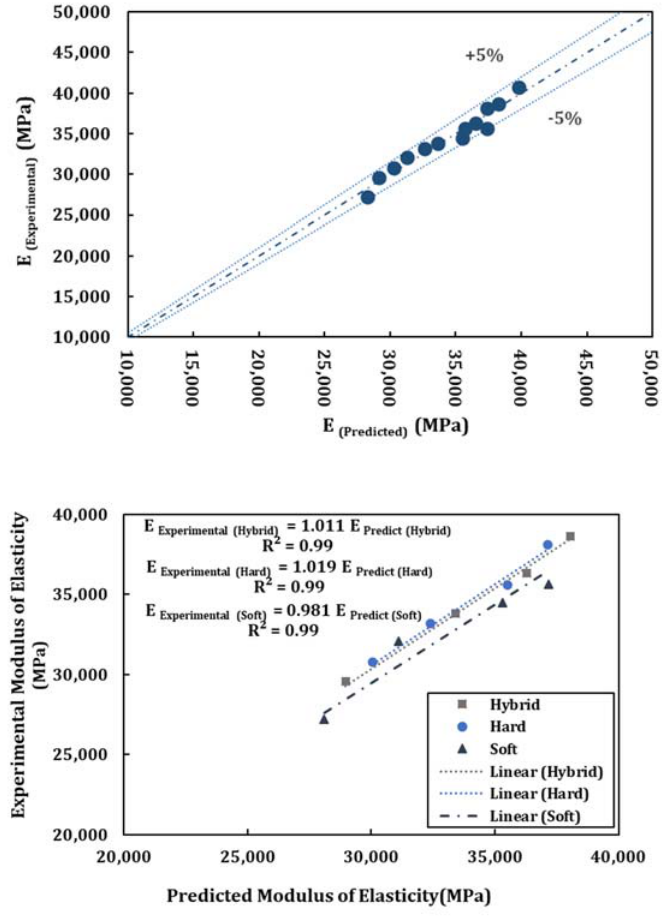
Figure 20. Experimental modulus of elasticity of the concrete containing BPW versus predicted values obtained from the Equation (3), and correction factors for each type of BPW.